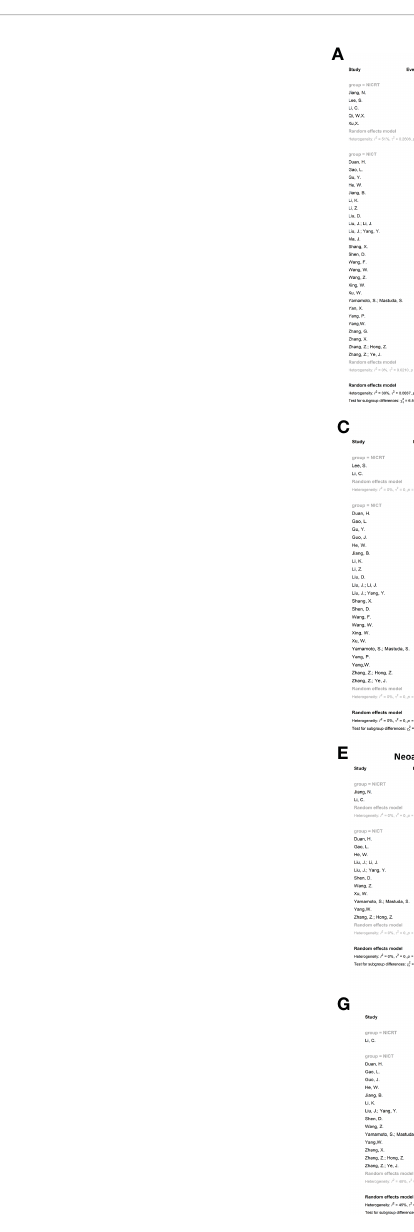
FIGURE 5 Forest plots of ef fi cacy and safety in ESCC. (A) Pathological complete response (pCR), (B) Major pathological response (MPR), (C) R0 resection rate, (D) Incidence of ≥ grade 3 TRAEs, (E) Neoadjuvant therapy completion rate, (F) surgical resection rate, and (G) Surgical delay rate. NICRT, neoadjuvant immune-chemoradiotherapy; NICT, neoadjuvant